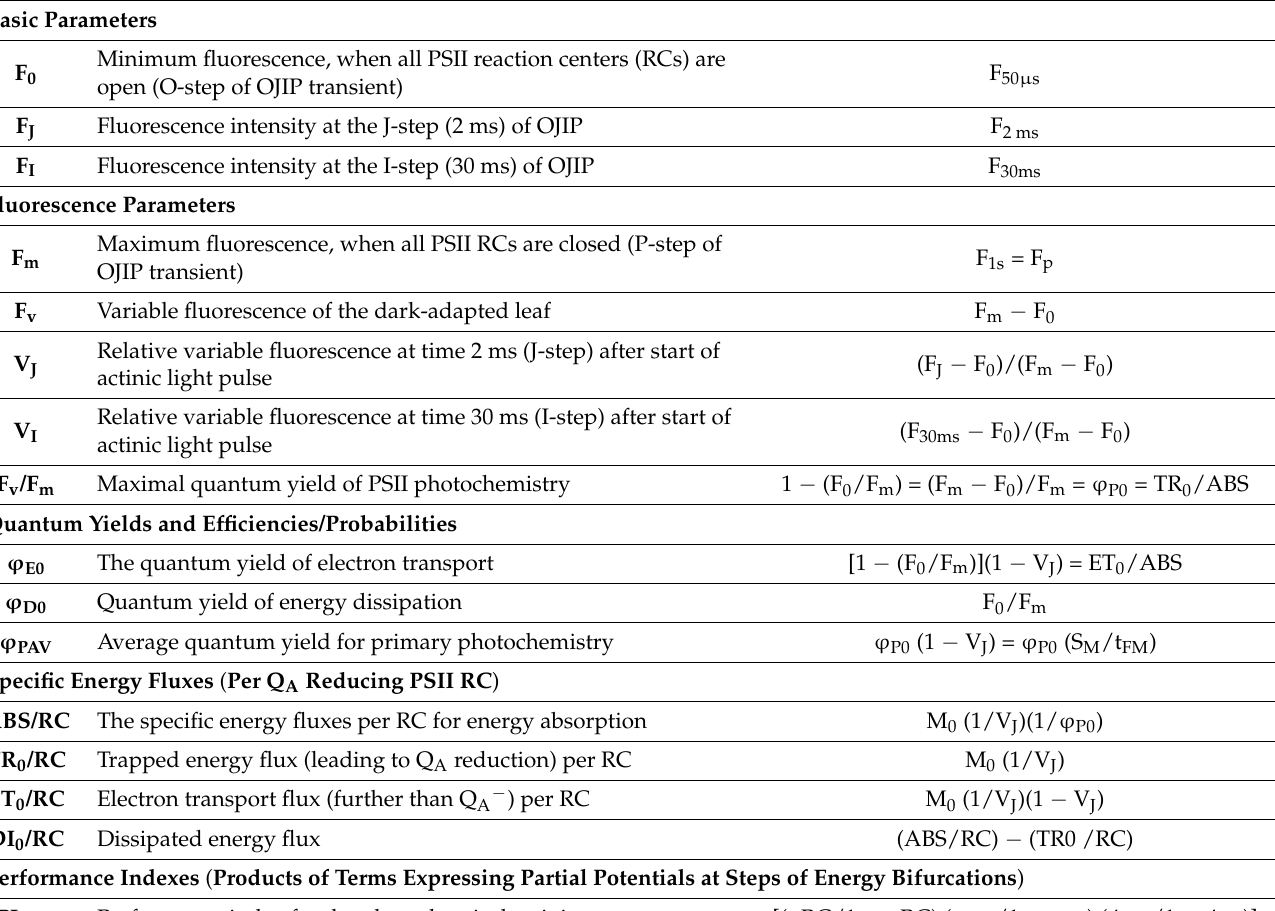
Table 2. Abbreviations, definitions, and formulas of the O–J–I–P parameters assessed in the current study. Basic